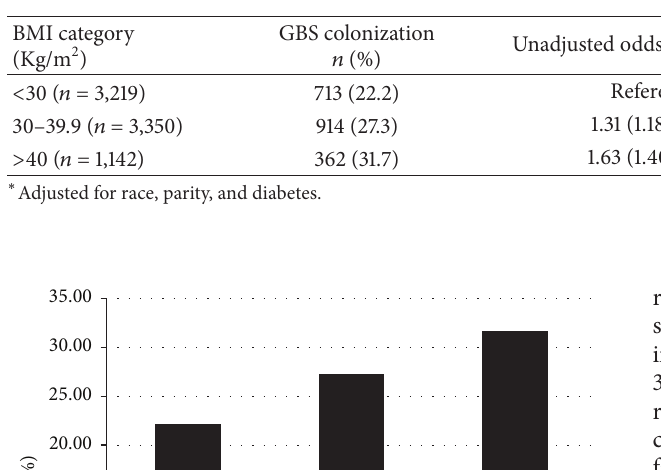
Table 2: Risk of GBS colonization with increasing obesity categories.